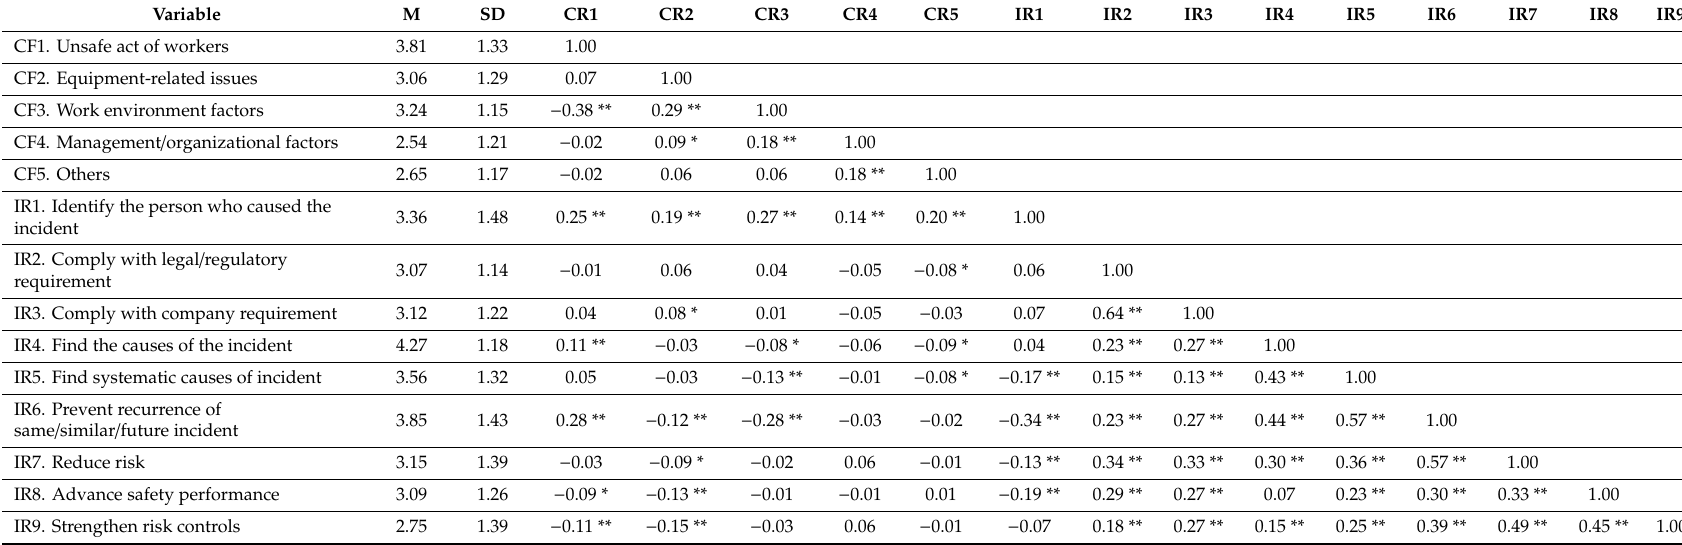
Table 4. Mean, standard deviation, and Pearson’s correlation (r) of the incident causal factors and the reasons for investigating incidents. Variable